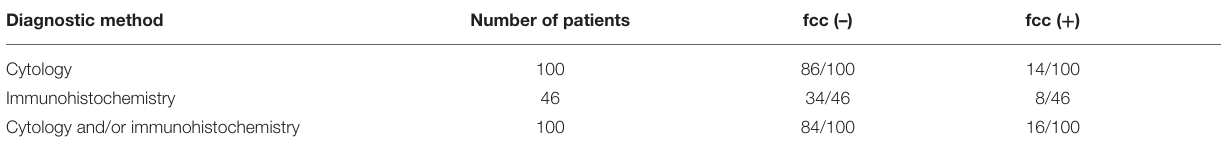
TABLE 2 | Results of peritoneal lavage examination for the presence of free cancer cells according to the diagnostic methods.